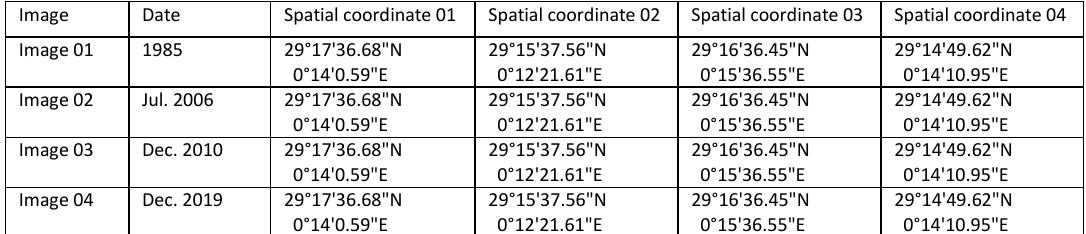
Table 1 The features of the images used for LU/LC change analysis.